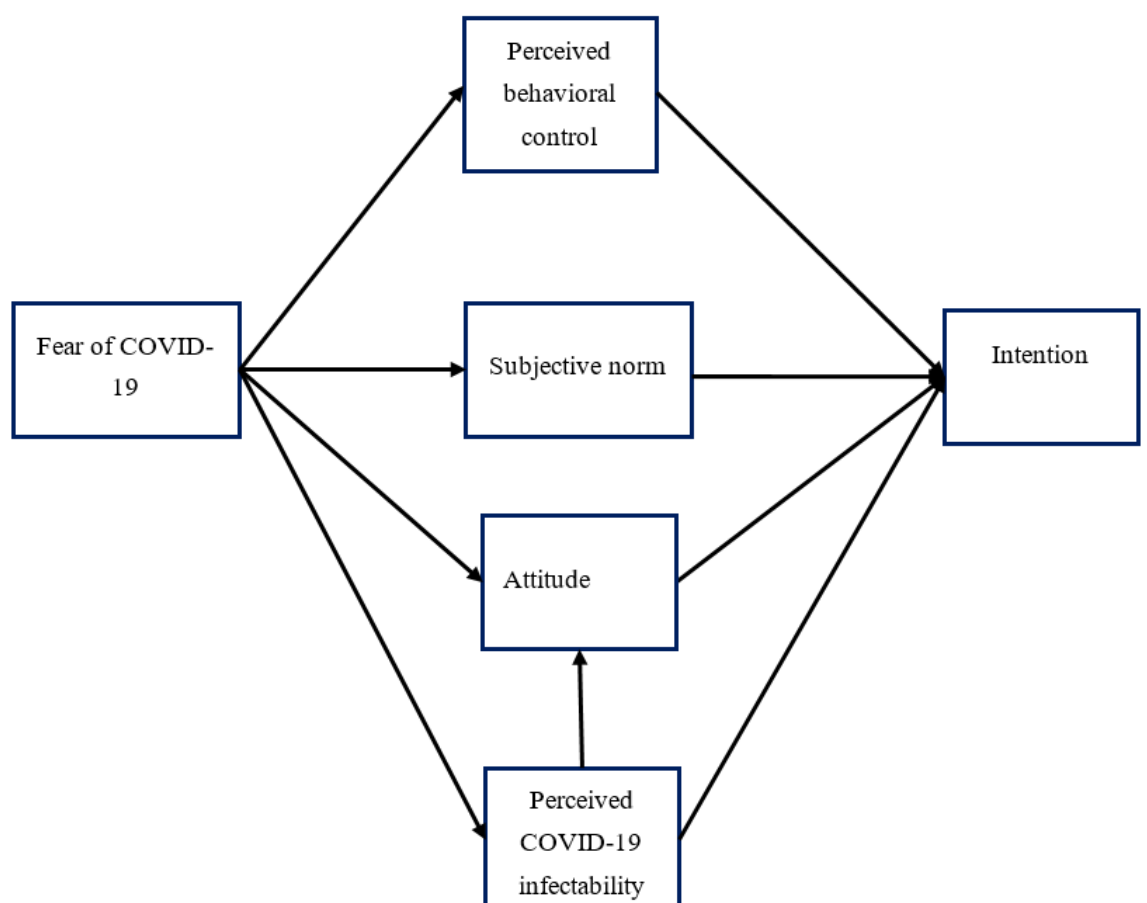
Figure 1. Proposed model to examine intention of COVID-19 vaccination uptake. Perceived behavioral control, subjective norm, attitude, and intention are constructs described in the Theory of Planned Behavior; fear of COVID-19 and perceived COVID-19 infectability are constructs described in Protection Motivation Theory.